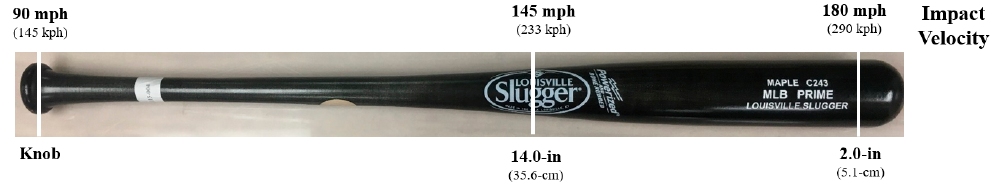
Figure 9. Impact speed variation by impact location.